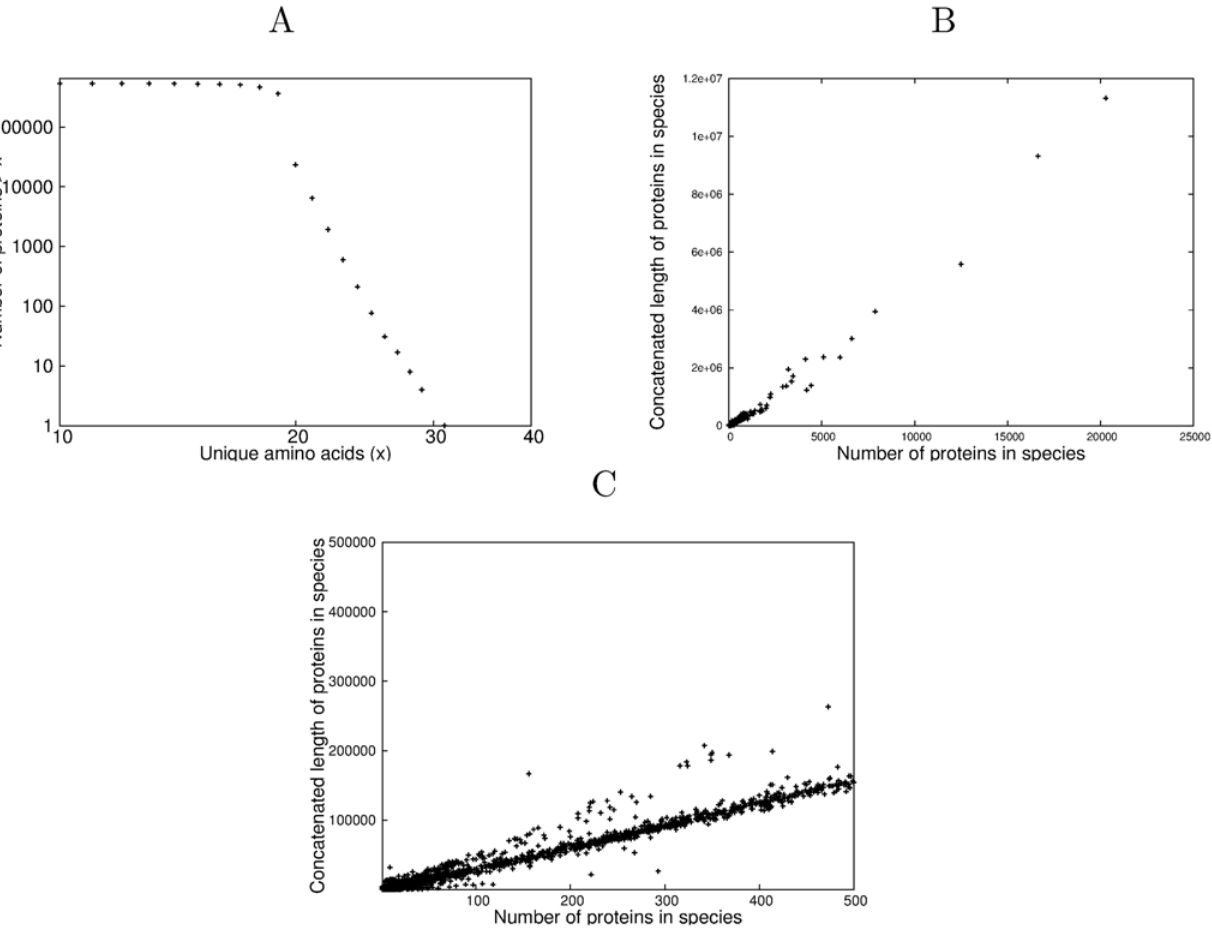
Fig 1. Unique amino acid distribution and average protein length. A Cumulative distribution function of unique amino acid count occurrence in proteins. The analysis encompassed all archaeal, bacterial, eukaryotic and viral proteins that were combined into the experimental PTM P exp subset [22]. B A plot of number of proteins against total length of those proteins for each species in SwissProt for unique counts from 1-30 amino acids. Each data point is one of the 13,041 species analysed C An expanded plot of the data in the bottom left hand corner of Fig 1B for species with less than 500 proteins, showing sub-